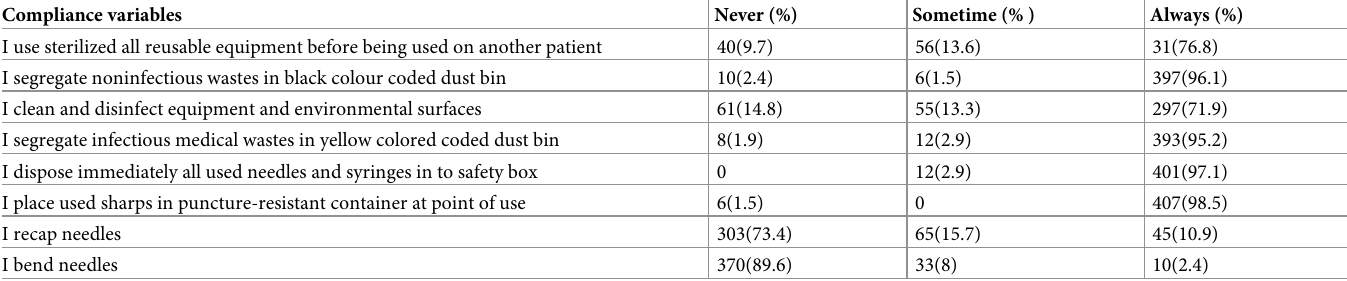
Table 4 below. In this study, female HCWs were 2.76 times more likely to be compliant with standard SP when compared with male HCWs. HCWs who had married were 4.2 times more likely compliant with standard SP when compared with single HCWs. HCWs who had accessi- bility of safety box 3.4 times more likely always compliant with standard SP. HCWs whose